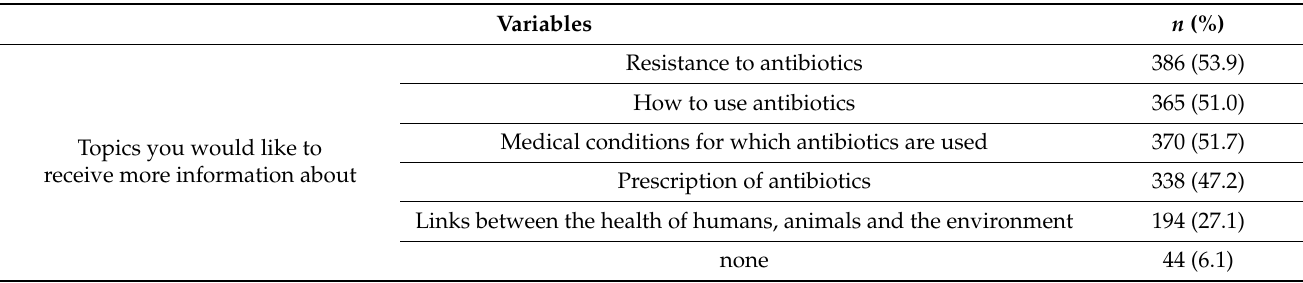
Table 8. Educational needs assessment in relation to antibiotic use and resistance.